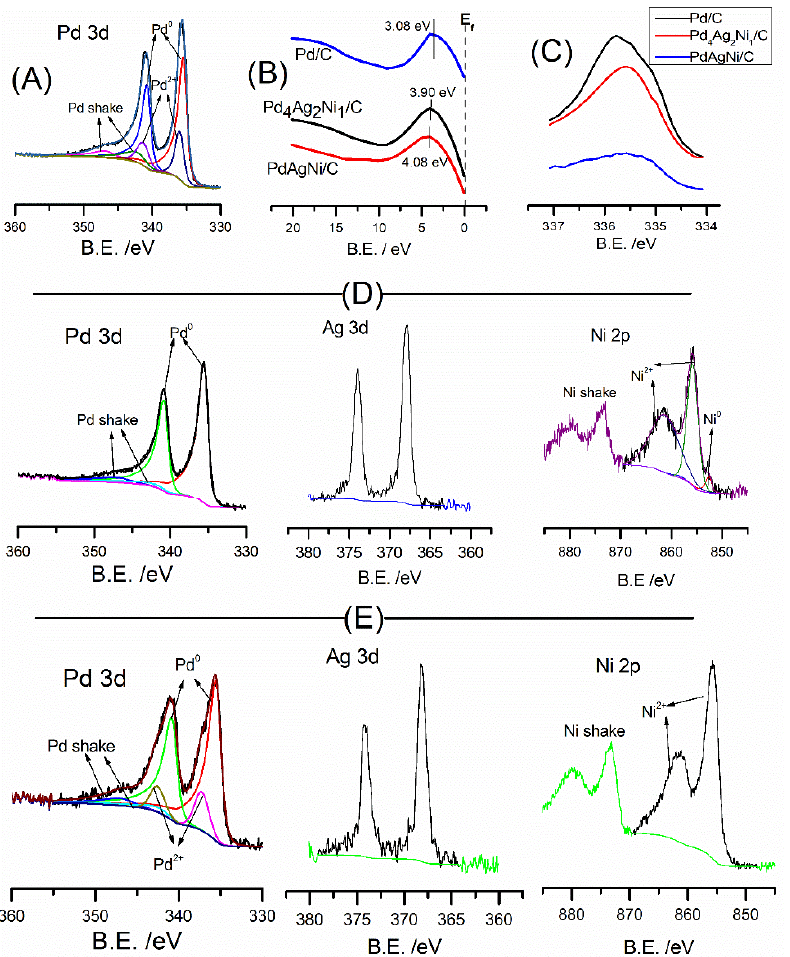
Figure 5. XPS elemental peaks of Pd 3d in in Pd/C ( A ), valence band spectra ( B ) and Pd 3d 5/2 ( C ) of Pd/C, Pd 4 Ag 2 Ni 1 /C, and PdAgNi/C, Pd 3d, Ag 3d, Ni 2p, of Pd 4 Ag 2 Ni 1 /C ( D ) and PdAgNi/C ( E ).